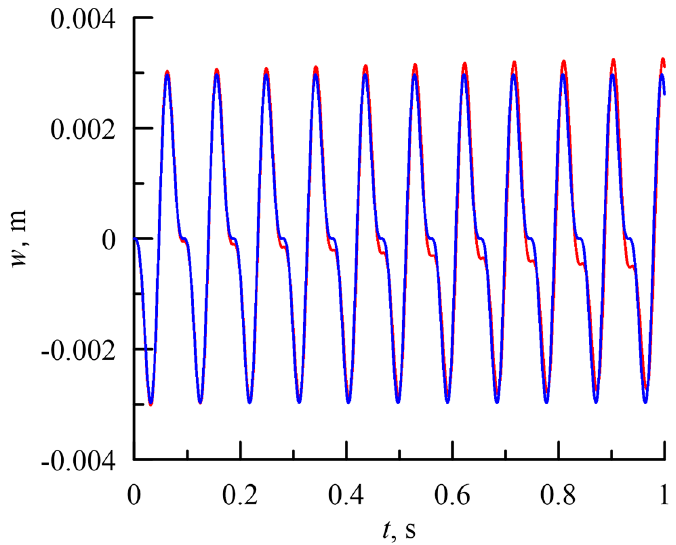
Figure 6. Time–history diagram of response of tip of beam subjected to uniformly distributed step load with p h = 200 N/m and ω e = 67.4 rad/s. load with p h = 200 N/m and ω e = 67.4